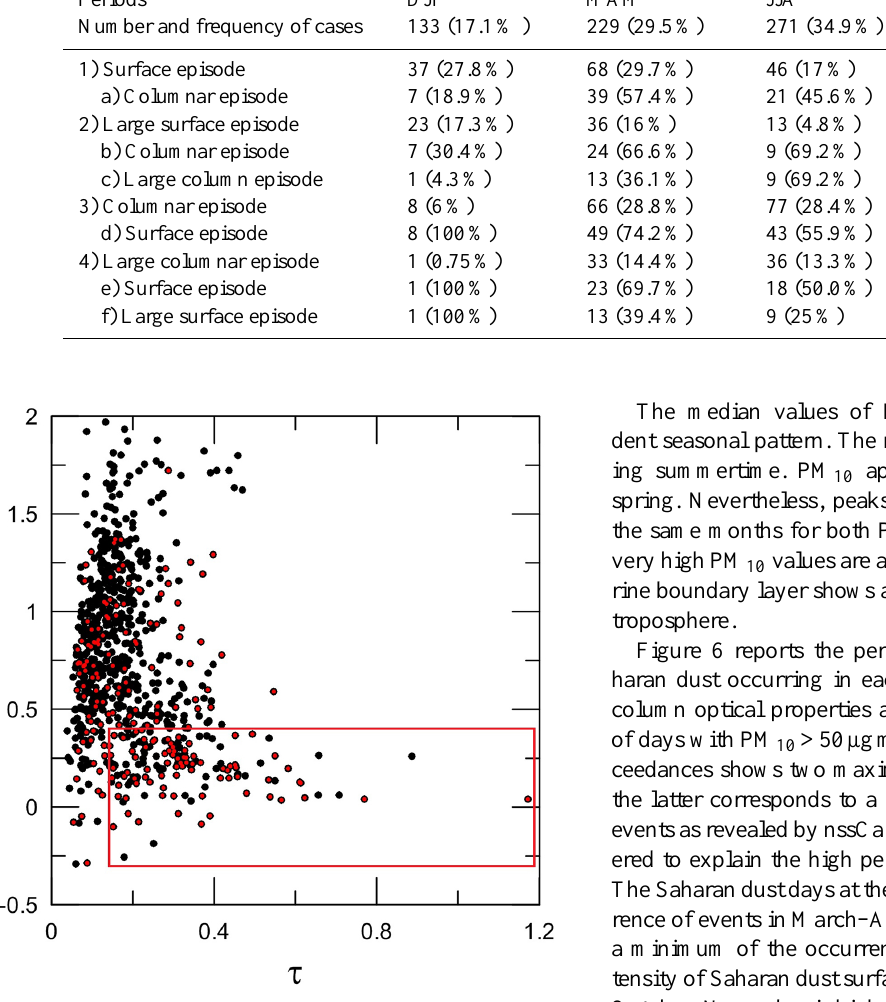
Fig. 4. Averages of the aerosol Ångström exponent versus aerosol optical depth at 495.7nm during the period June 2004–September 2010 for the days with PM 10 ion analyses and for cloud-free pe- riods, when aerosol optical depths measurements re possible. The red dots represent days with nssCa >483ngm − 3 , i.e. elevated dust at the surface. The dots inside the red square represent the Saharan dust events selected by τ >0.15 and α <0.5 as reported in Pace et al.,